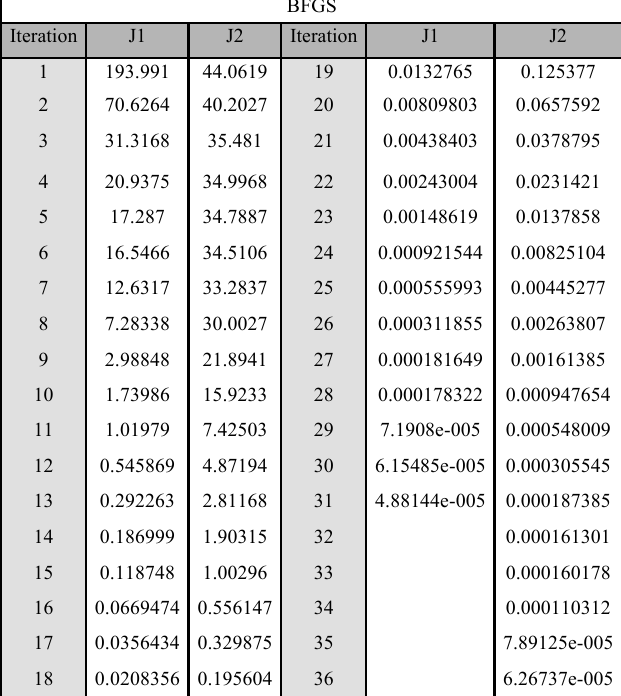
Table 1: BFGS iterations converging towards 0